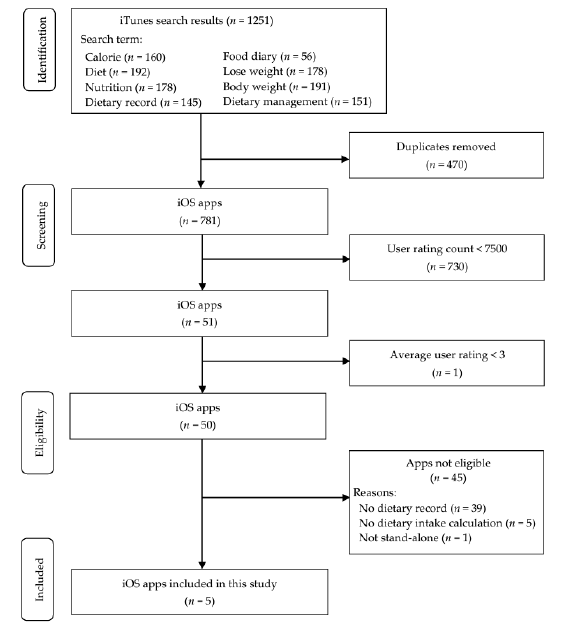
Figure 1. Flowchart for App Search